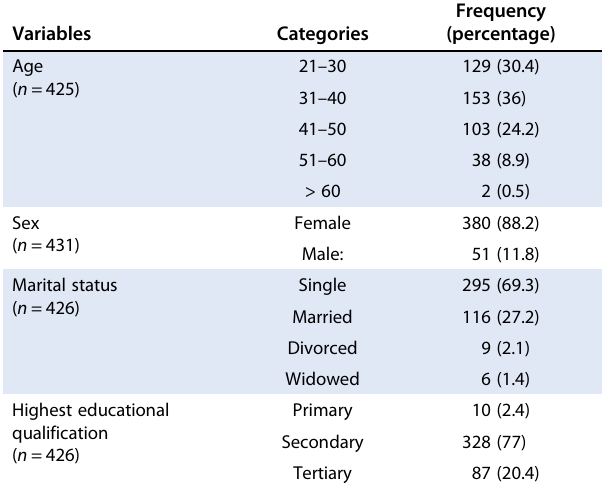
Table 2: Responses received from CHWs concerning satisfaction